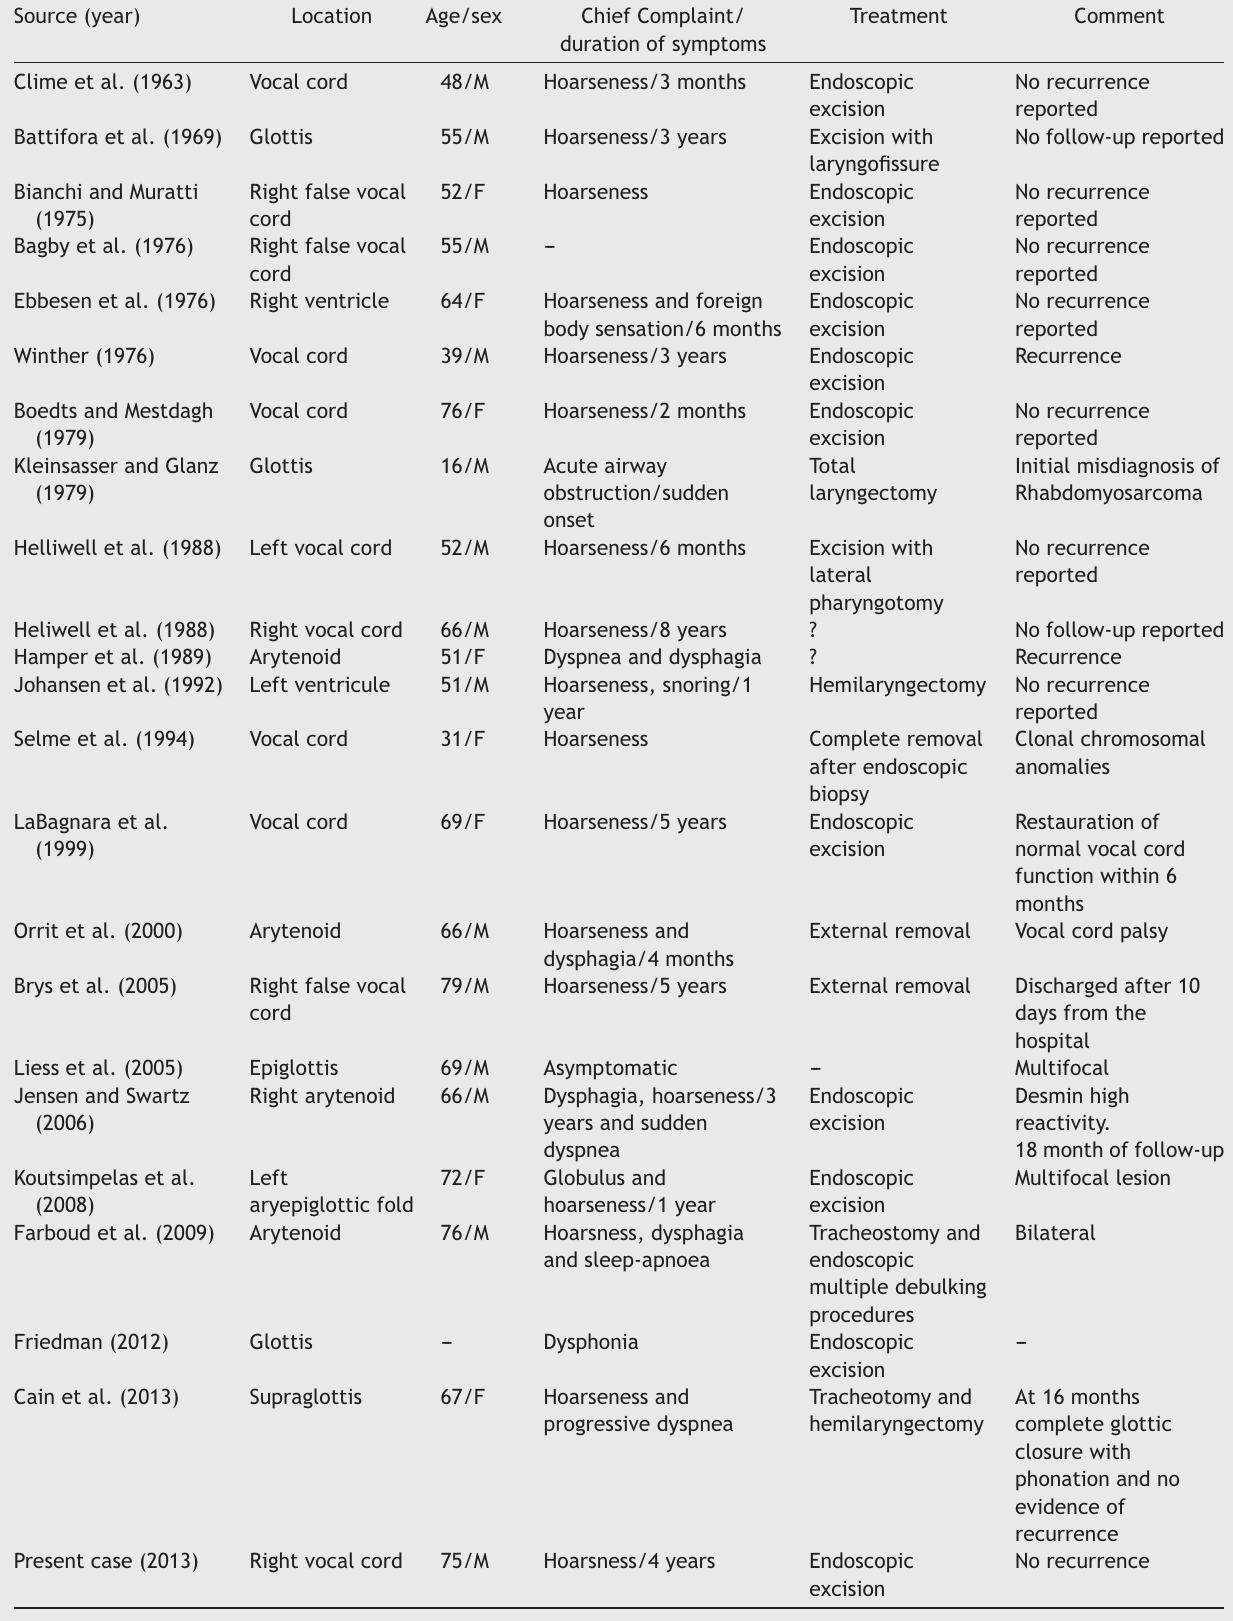
Adult-type laryngeal